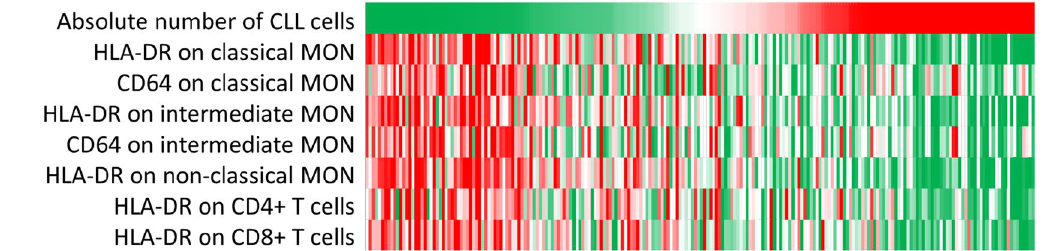
Figure 1. Heat map illustrating the relationship between expression of activation markers on immune cells and the CLL cell counts. Each column represents an individual CLL patient; the rows represent the CLL cell counts (× 10 9 cells/L) or the expression levels of studied markers, respectively. Each cell is coloured based on the CLL cell counts or the level of expression (MFI) of HLA-DR and CD64 on the populations in that patient, from the lowest (green) to the highest (red)